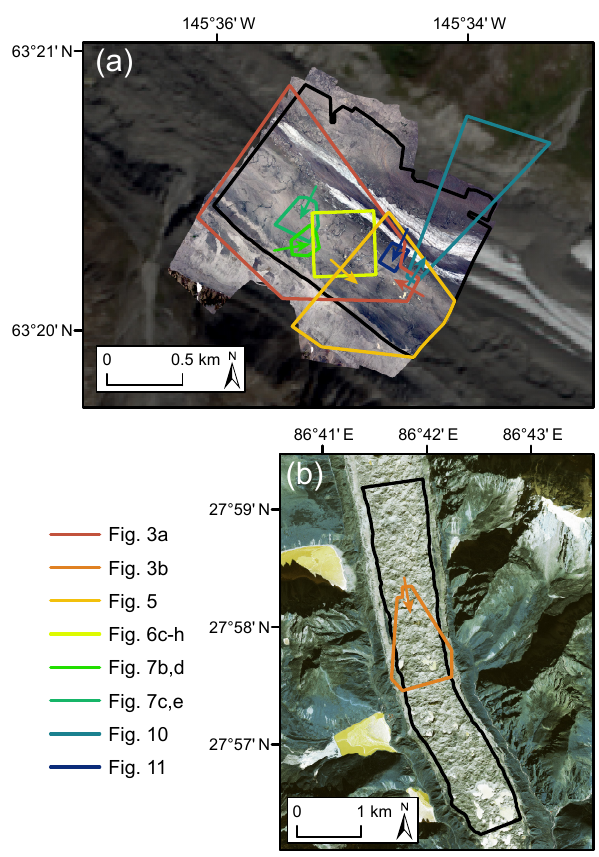
Figure 2. Study area on Canwell Glacier (a) and Ngozumpa Glacier (b) . The spatial domains over which the ice cliff mapping method was applied are shown in black. The footprint of subsequent map-based figures within this paper are shown. Arrows show the look direction of figures that have an oblique orientation. The un- derlying imagery shown in panel (a) is the orthomosaic collected on 29 July 2016 (Sect. 2.2.1) overlain on a Landsat8 image (path/row: 67/16) acquired on 31 August 2016; and (b) the GeoEye-1 image acquired on 23 December 2012 (Sect.